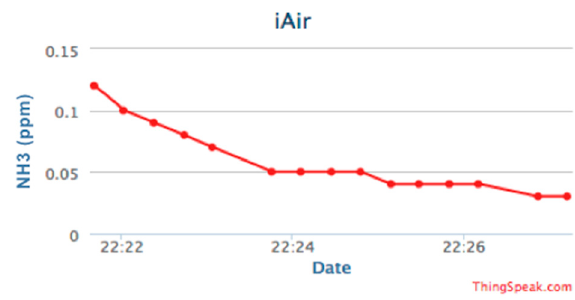
Figure 4. NH 3 concentration (ppm); data obtained in the tests performed.